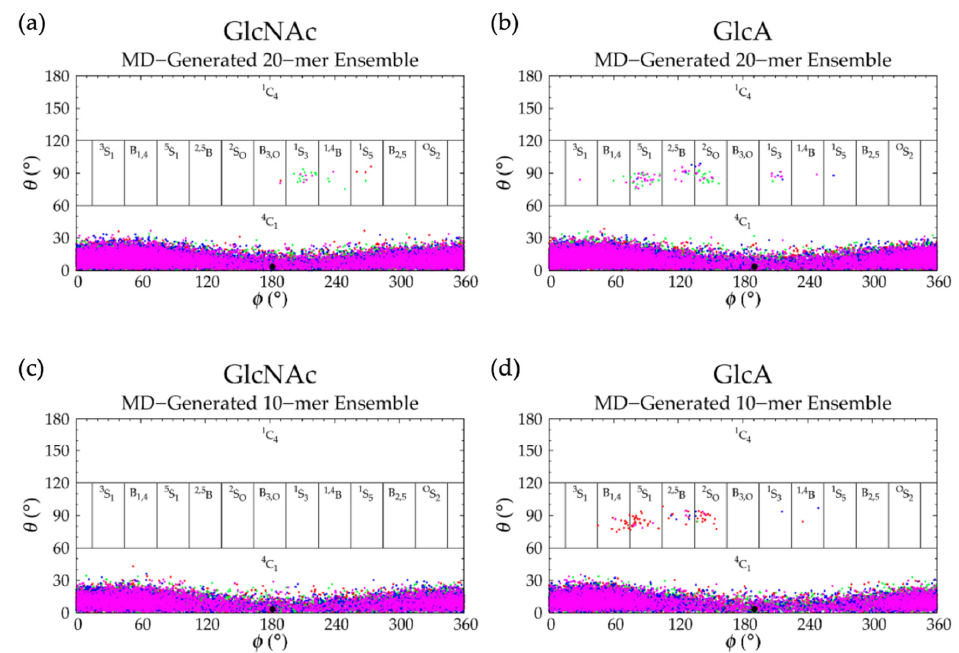
Figure 3. Cremer–Pople data for MD-generated hyaluronan ensembles: ( a ) GlcNAc and ( b ) GlcA in the 20-mer and ( c ) GlcNAc and ( d ) GlcA in the 10-mer; geometries from the four sets of each ensemble are represented by red, green, blue, and magenta dots, respectively and the force-field geometry is represented by a single large black dot; Cremer–Pople parameters ( φ , θ ) for all rings in every tenth snapshot from each ensemble were plotted (i.e., 10 rings × 1,000 snapshots per run × 4 runs = 40,000 parameter sets for the 20-mer and 20,000 parameter sets for the 10-mer).